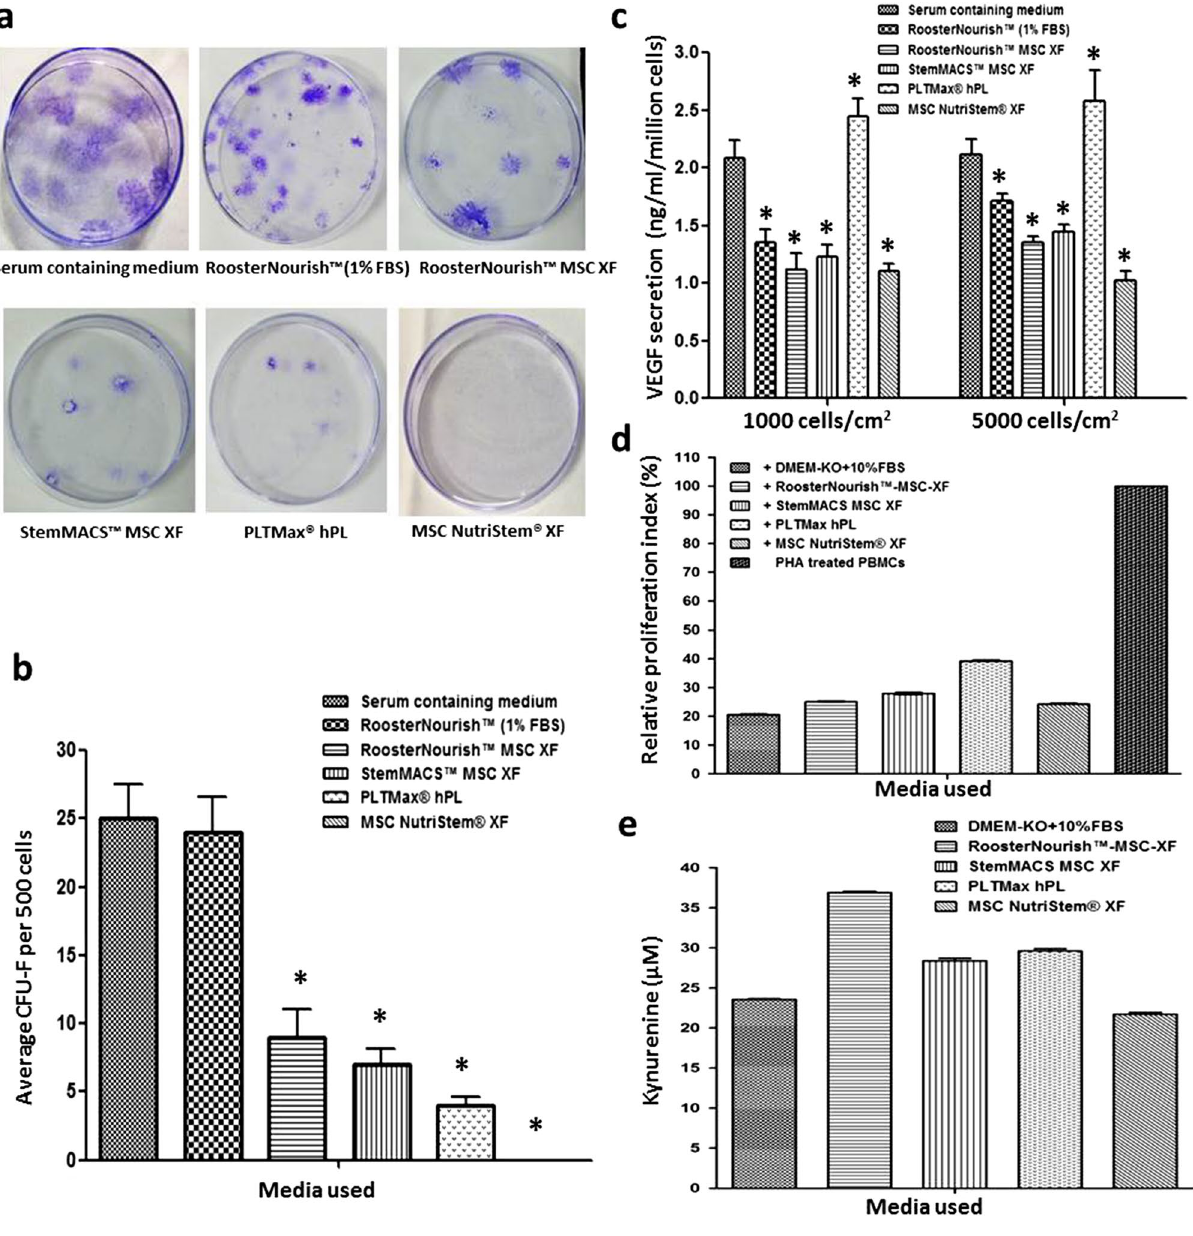
Figure 8. Colony forming ability, potency and immunosuppressive potential of BM-MSCs cultured in SFM/ XFM and control medium. ( a ) Representative photograph of CFU-F of BM-MSCs grown in low serum/ SFM/ XFM and control medium. ( b ) Bar graph showing the number of colonies of BM-MSCs cultured in low serum/ SFM/XFM and control medium. The data is represented as mean ± SD (n = 2; *p < 0.05). ( c ) Cryopreserved cells were seeded into T-75 flasks post revival and grown in respective media for 72 h and the amount of VEGF secreted was determined by ELISA. Results are expressed in concentration (ng/ml/million cells) as mean of duplicate experiment. The amount of VEGF secretion was higher in BM-MSCs cultured in PLTMax hPL when compared to other media and control medium. ( d ) Bar graph shows the percentage proliferation of PHA stimulated T cell blasts in MSC: PHA activated PBMC co-cultures cultured in SFM/XFM and control medium. The proliferation index in co-cultures is relative to proliferation in PHA blasts (cultured in the absence of MSCs) which was considered as 100% ( e ) To determine IDO enzyme activity, the culture supernatant of MSC: PHA activated PBMC co-cultures of different media groups was assayed by spectrophotometric detection of the kynurenine concentration (tryptophan metabolite which is a product of IDO catabolism) and is represented as Kynuerurine units (μM). IDO secretion was higher in co-cultures cultured in SFM/XFM when compared to serum-containing